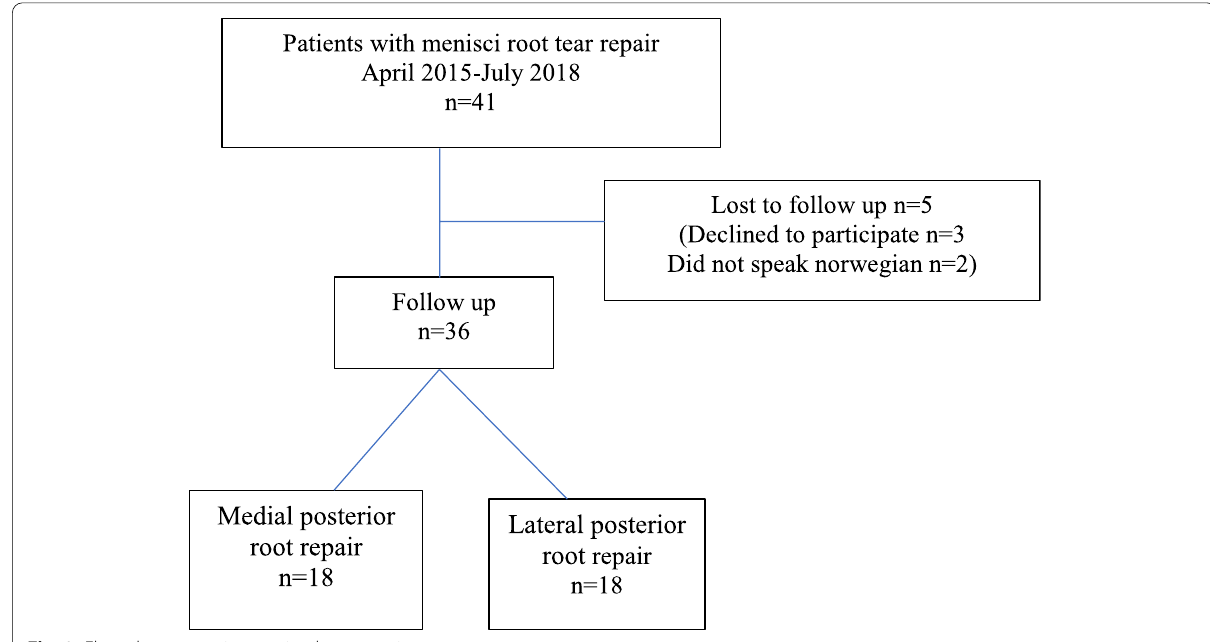
Fig. 2 Flow chart posterior meniscal root